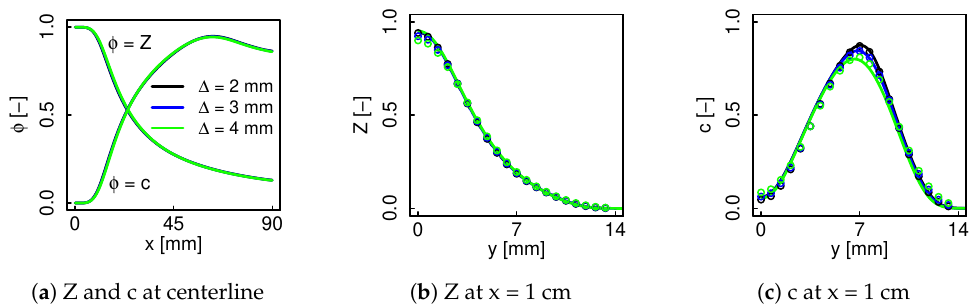
Figure 9. Mixture fraction and progress variable centerline and radial profiles for three different filter sizes. The manifolds are generated by direct flamelet filtering, the filtered tabulated chemistry correction terms being omitted.